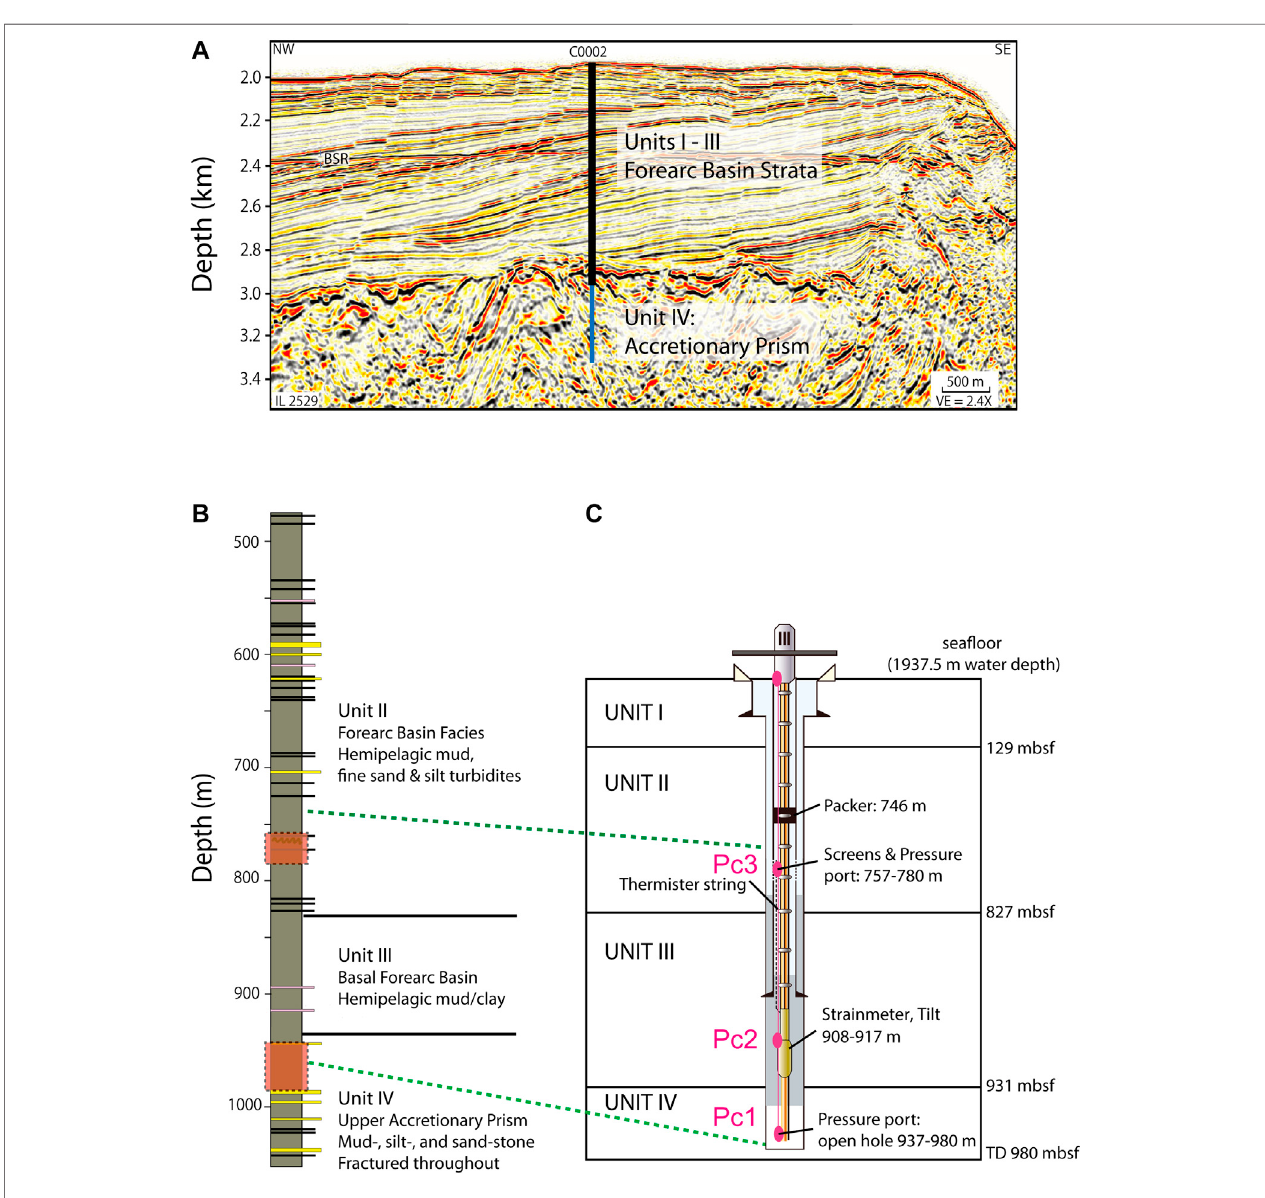
FIGURE 2 | (A) Seismic section showing the location of the borehole observatory installation at C0002. (B) Schematic stratigraphic column. Gray: clay and mudstone. Black: silt. Yellow: sand. Pink: ash. (C) Borehole completion diagram. The solid magenta ellipses indicate the pressure gauges, where the top one is a hydrostatic reference pressure sensor used to remove oceanographic signals. This fi gure is modi fi ed after the Supplemental Material of Araki et al. (2017).